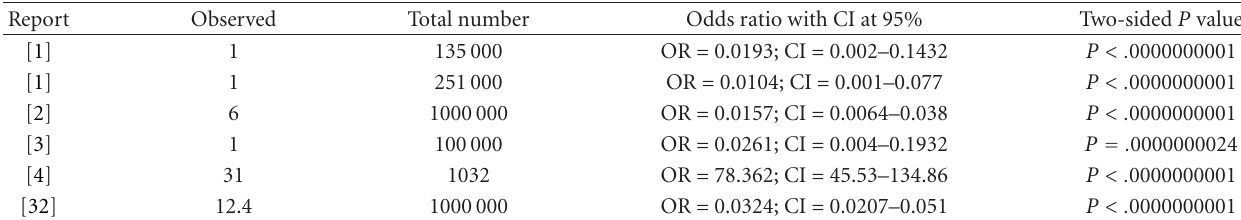
Table 2: Odds ratio of observed serodeconversion rate, that is, 23 out of 60,000 patients, in comparison to published incidence rate of erroneous HIV